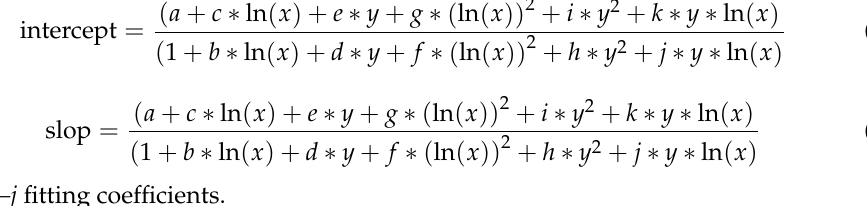
Figure 6. Left: Intercepts (top) and slopes (bottom) of the dependency of the CaO demand of soils on the soil pH, mean particle diameter (MPD) and soil organic matter (SOM) content as calculated based on the linear relationships given by the VDLUFA approach and shown in Figure 2 (dots) and calculated according to Equations (7) and (8) (surfaces). Right: Intercepts (top) and slopes (bottom) calculated by Equations (7) and (8), respectively, predicted (Model) vs. observed (VDLUFA).